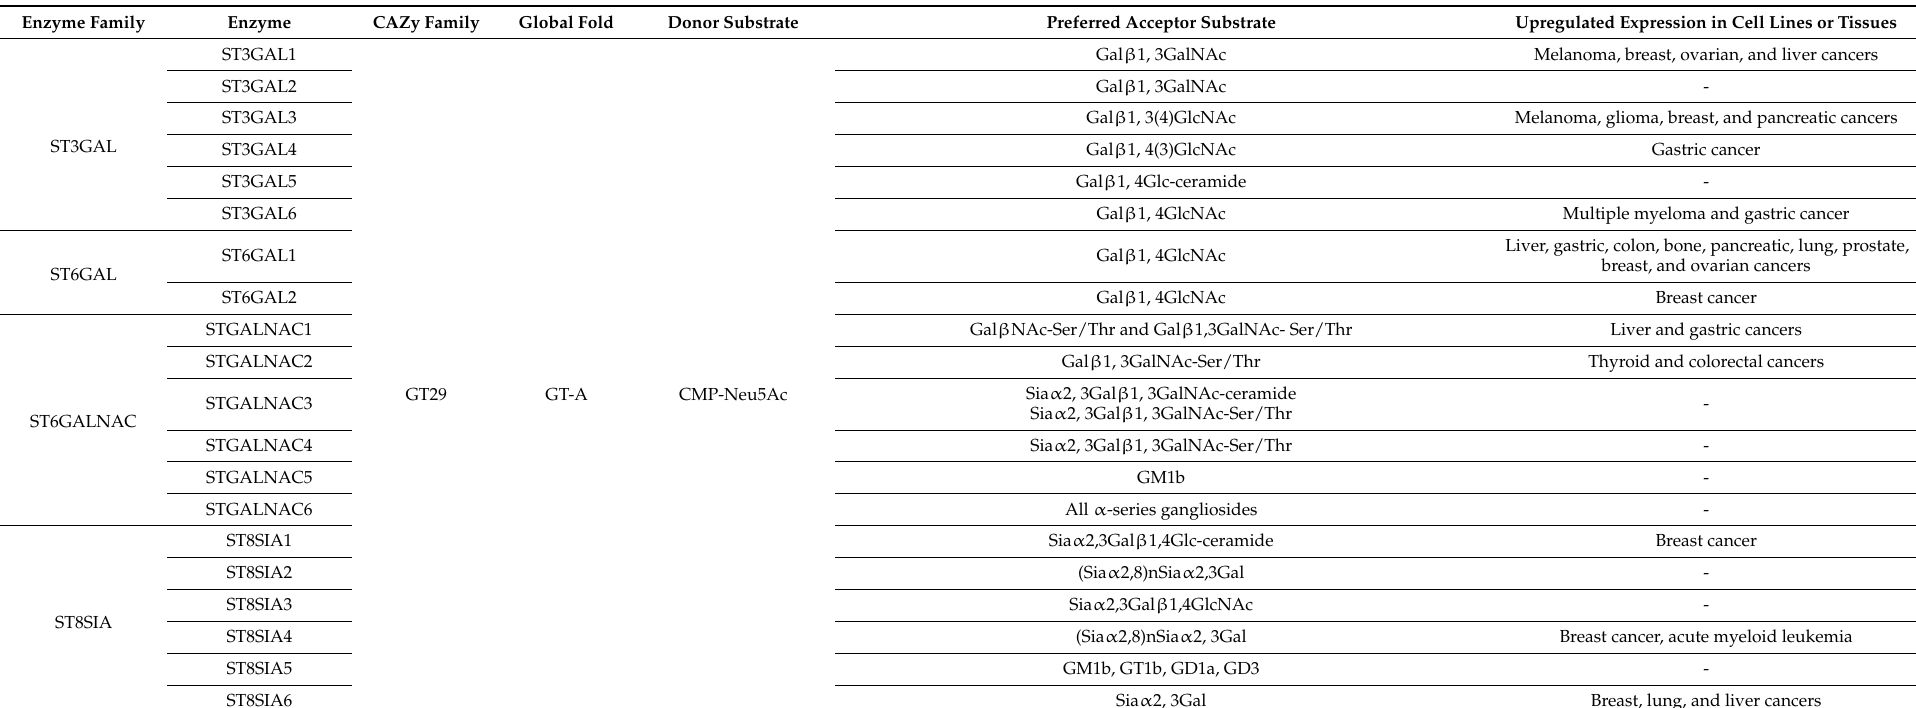
Table 1. Features of known STs and FUTs in humans and upregulated expression in